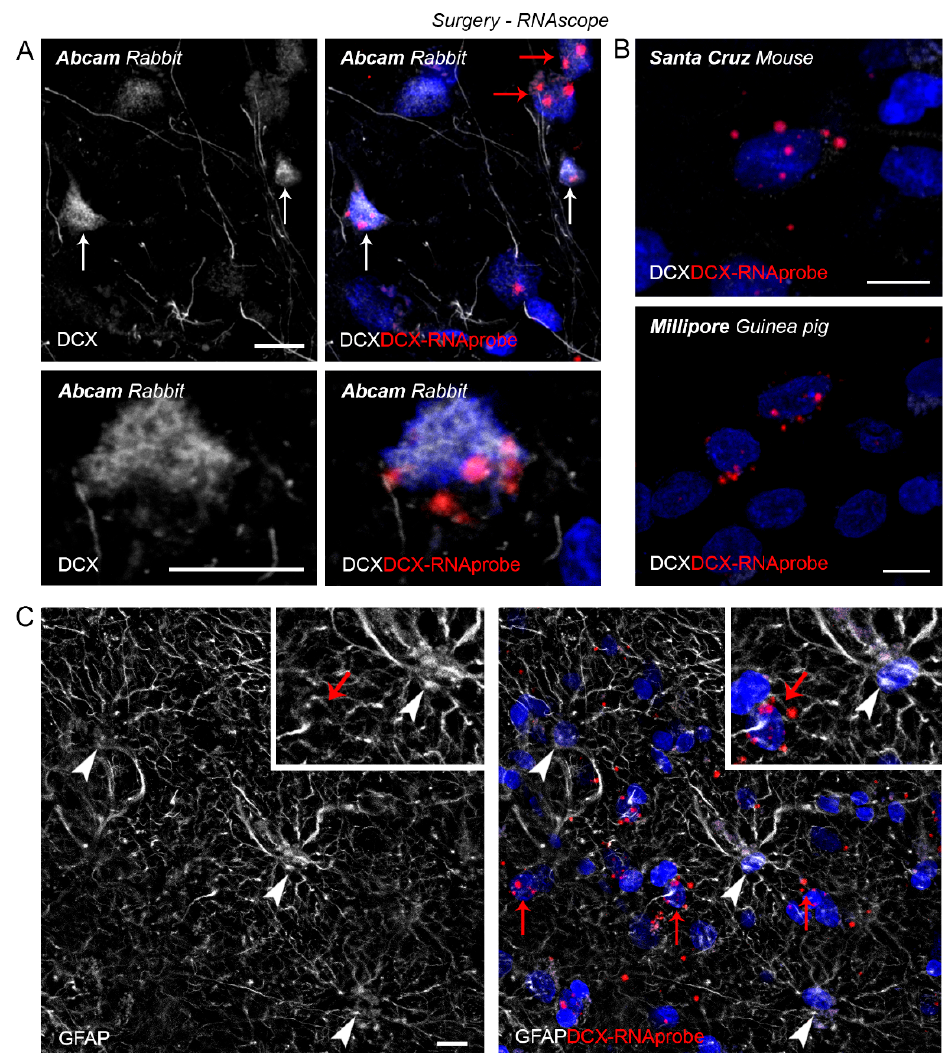
Figure 9. Detection of DCX in the human neocortex by RNAscope. ( A ) RNAscope technique in association with anti-DCX Abcam primary antibody confirms that some labelled cells in layer II-III actually are DCX-expressing cells (white arrows); some cells positive only for the RNA-probe do not express the protein (red arrows); bottom, higher magnification of a doule-labelled cell. ( B ) No co-expression of DCX-RNAprobe (red arrows) with anti-DCX Santa Cruz and Millipore. ( C ), No co- expression of DCX-RNAprobe (red arrows) with GFAP+ astrocytes (white arrowheads) was detected. Scale bars: 10 µm.